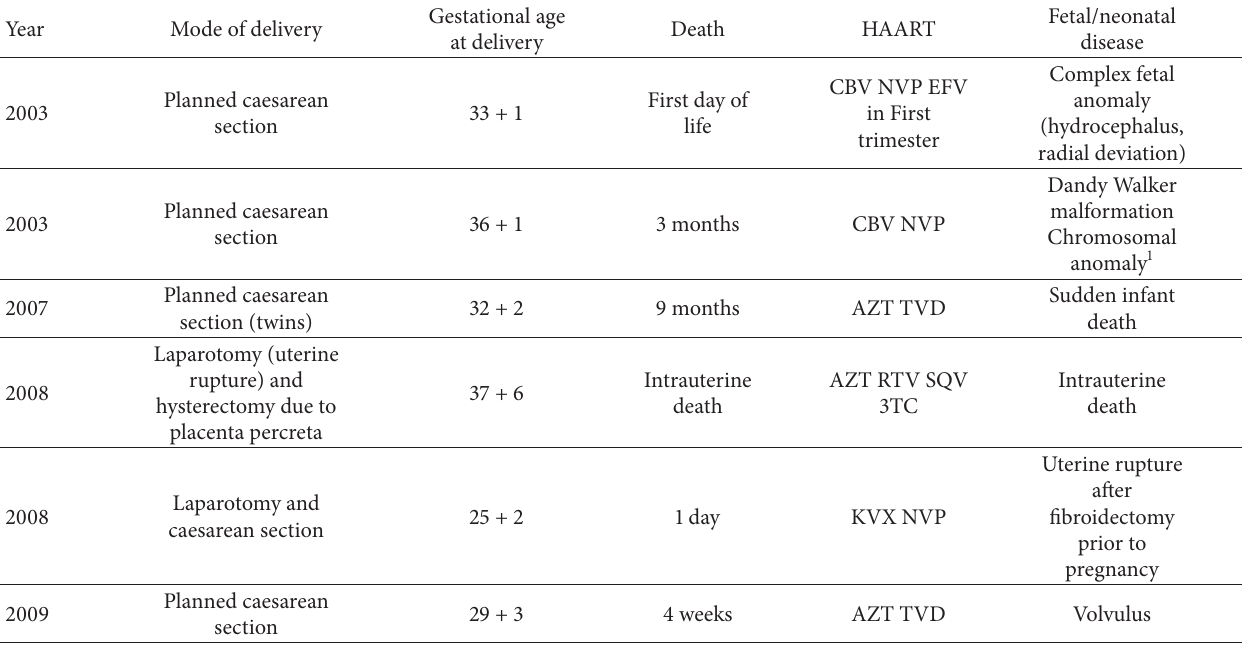
Table 5: Neonatal Mortality.